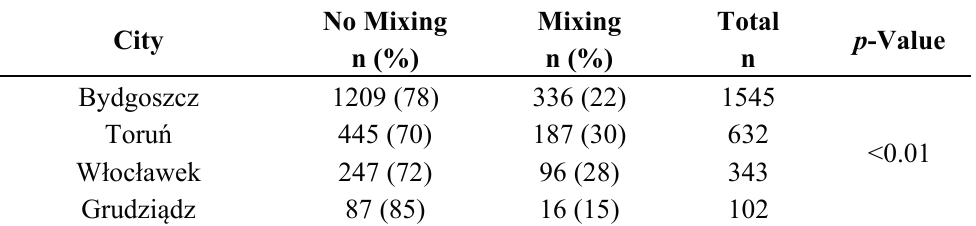
Table 5. Consumption of energy drinks mixed with alcohol in different